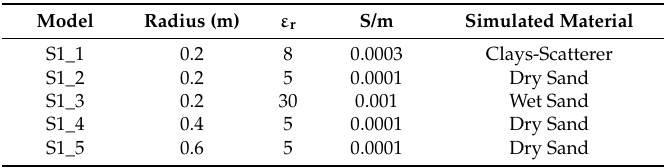
Table 1. Characteristics of the scatterers in the five analysed